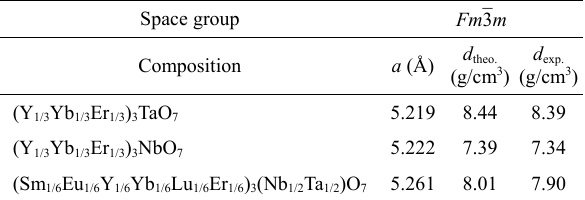
Fig. 1 XRD patterns of the as-synthesized Y 3 TaO 7 , Y 3 NbO 7 , and HE RE 3 TaO 7 , RE 3 NbO 7 , and RE 3 (Nb 1/2 Ta 1/2 )O 7 powders. Table 2 Refined lattice parameters of HE RE 3 TaO 7 , calculated theoretical densities ( d theo. ) and the experimental measured densities ( d exp. )